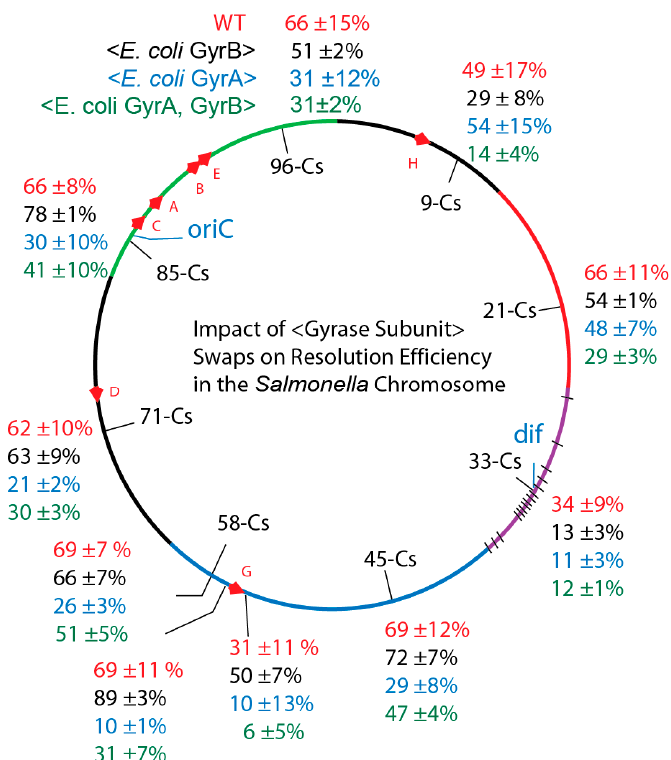
Figure 4. In vivo resolution assays of Salmonella e with precise chromosomal swaps of E. coli GyrA and GyrB subunits exploited supercoil reporters in six chromosome macrodomains. Macrodomain in Salmonella genome segments correspond to the six macrodomains of the E. coli chromosome: Ori-green; Right; Unstructured - black; Right, red; Ter, purple with black hatches showing matS sites; Left Domain, blue; Left unstructured domain, black. Resolution efficiencies at 10 positions are shown for: Salmonella WT, red; Strains with the E. coli GyrB transgene, black; Strains with E. coli GyrA, blue; and Salmonella with E. coli GyrA + GyrB, green.